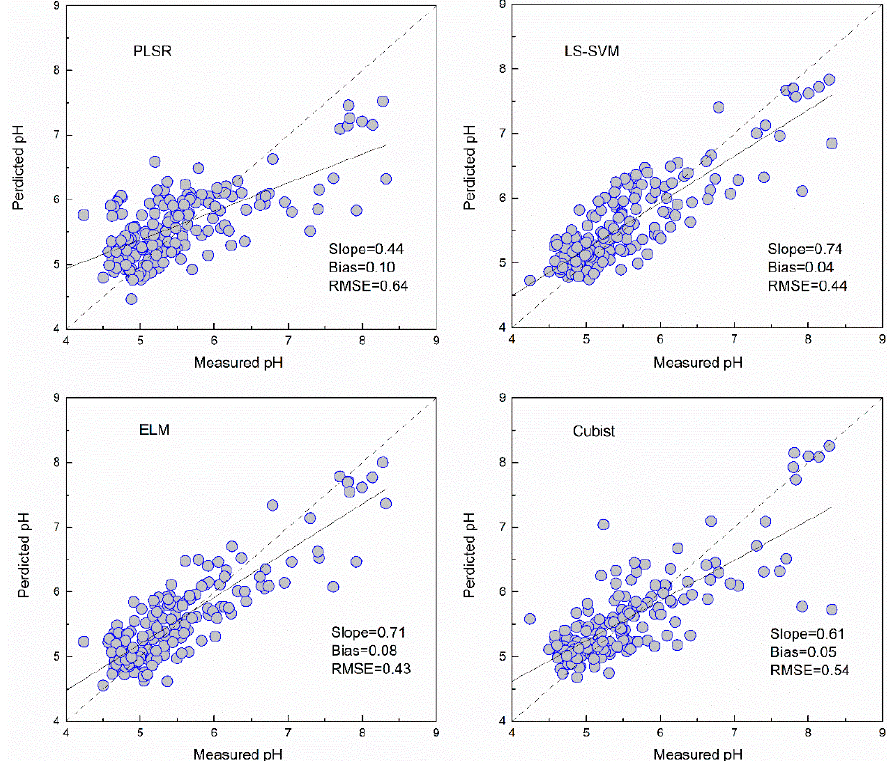
Figure 8. Predicted values against measured values of the validation set for pH using the PLSR, LS-SVM, ELM and Cubist methods with bands selected by GA.